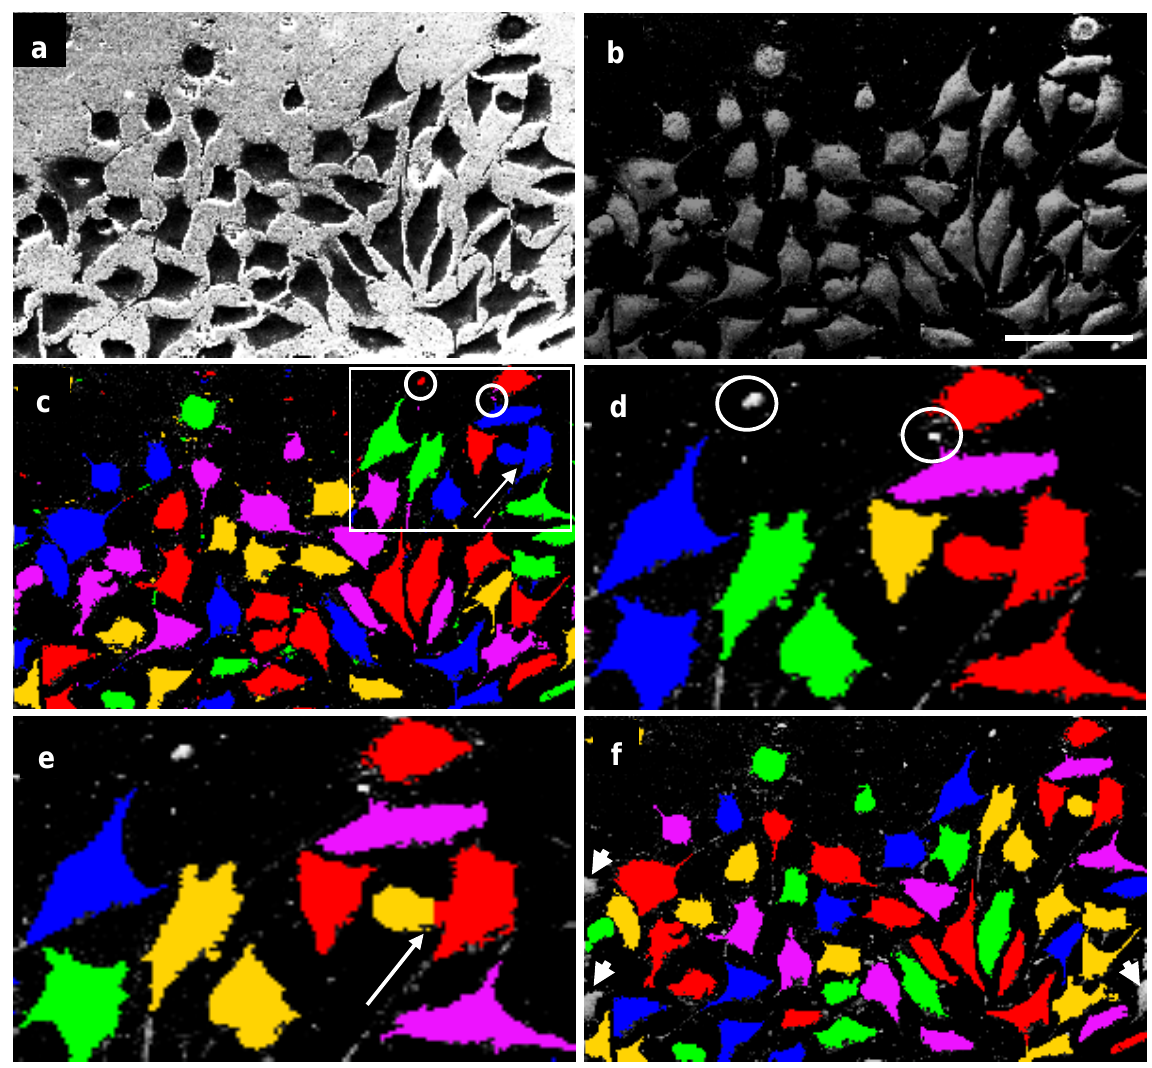
Figure 6. Image processing steps of BSE-images; (a) original image; (b) subtraction of background information after image inversion; (c) threshold segmentation: rectangle marked part of image shown in d and e; (d)-trouble shooting (objects marked in c and d with circles); (e) splitting of cells by distance (cells marked in c and e with arrow); (f) final image after removing of fragmentary border cells (arrow heads). Scale bar: 100 μ